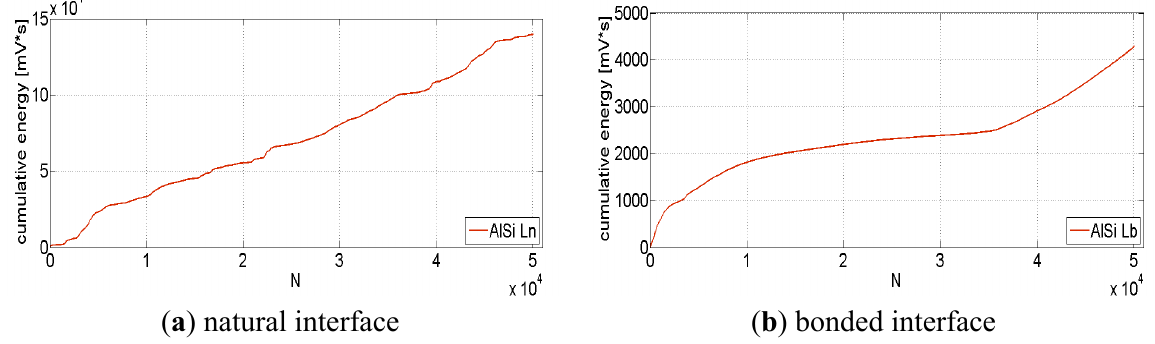
Figure 14. Cumulative energy of the acoustic emission signal during the cyclic test; specimens AlSi Ln ( a ) and AlSi Lb ( b